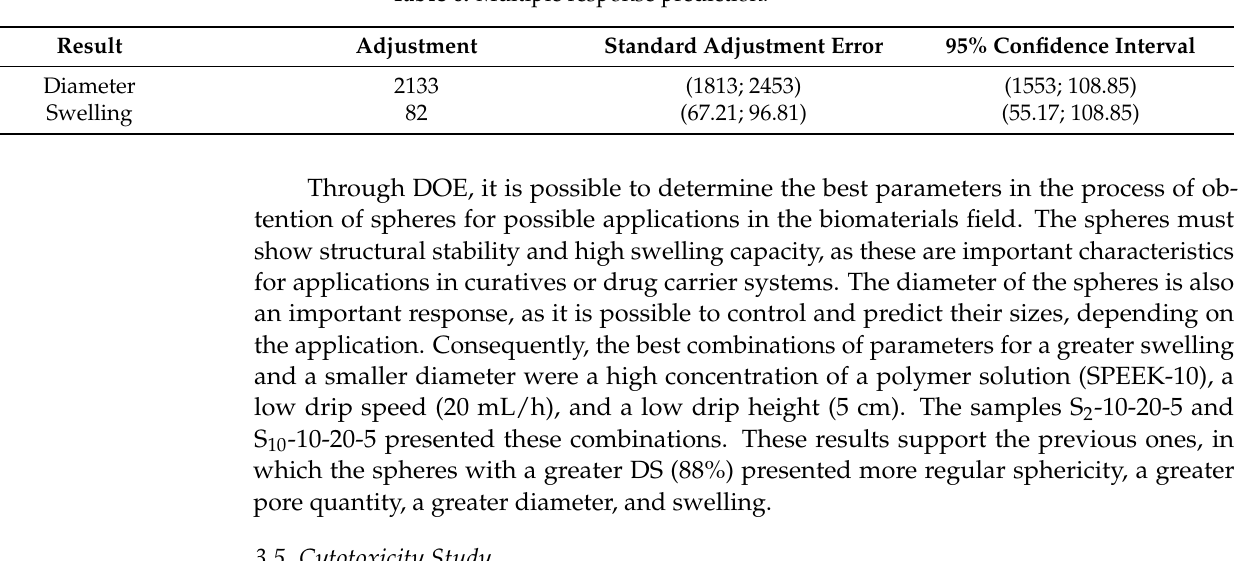
Table 6. Multiple response